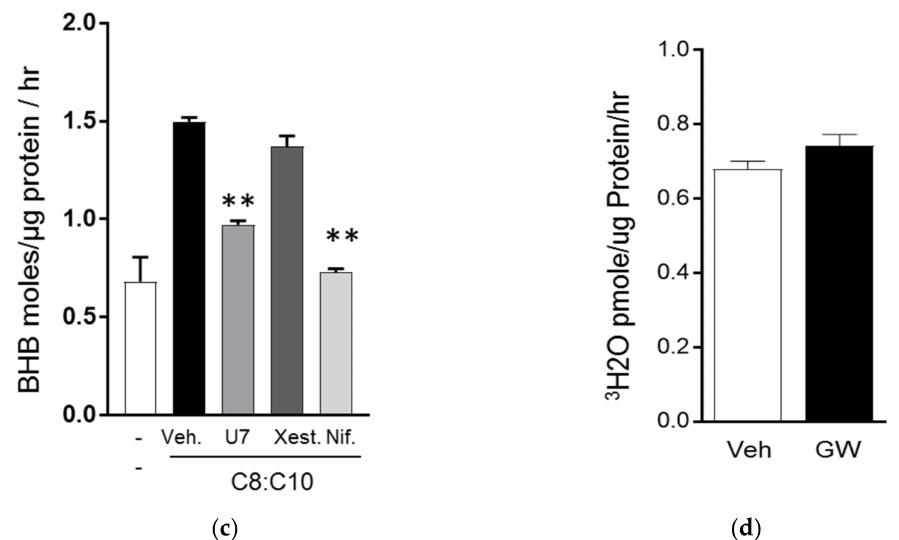
Figure 3. GPR40 signaling affects fatty acid β -oxidation in β -cells. ( a ) Ketone body β - hydroxybutyrate (BHB) production in INS1E β -cells in the presence of C8, C10 or C8:C10 40:60 mixture. ( b ) Inhibition of GPR40 signaling by the antagonist, GW1100 (GW), ( c ) the phospholipase C- β (PLC β ) inhibitor, U73122 (U7) and nifedipine (Nif) prevent BHB production from medium chain fatty acids (MCFA) in INS1E β -cells unlike the IP3 receptor inhibitor xantospongin (Xant). ( d ) Inhibition of GPR40 signaling